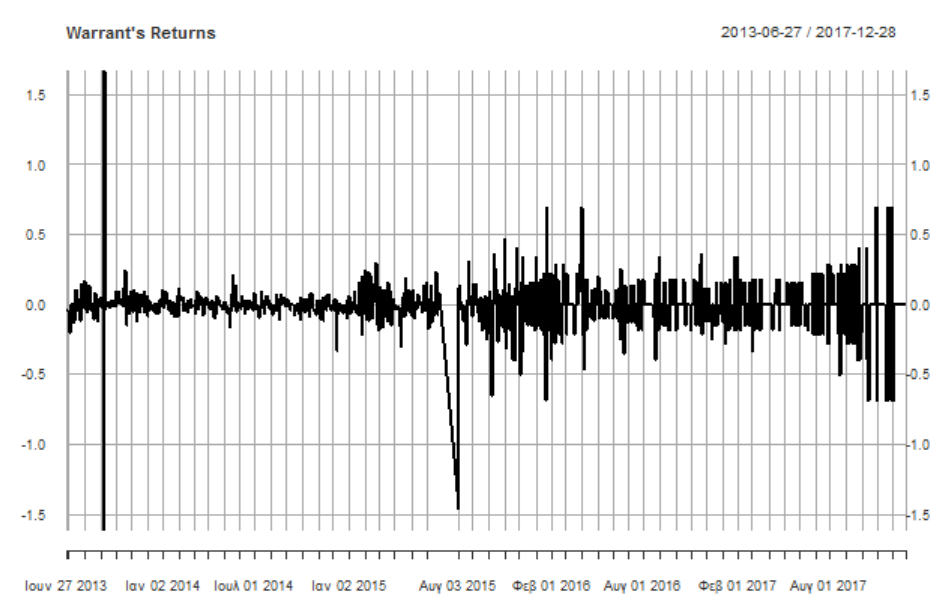
Figure 2. NBG warrants - returns